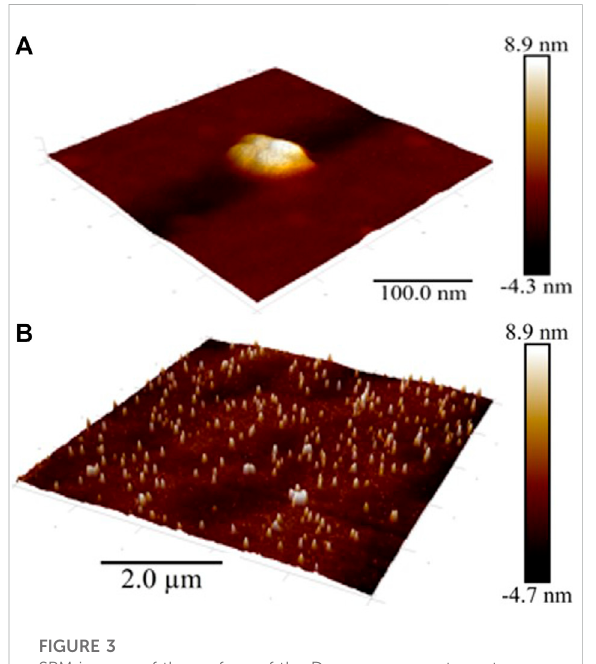
FIGURE 3 SPM images of the surface of the Dox aqueous system at 1 · 10 − 11 M Scale bar: (A) 100 nm, (B) 2 µm.